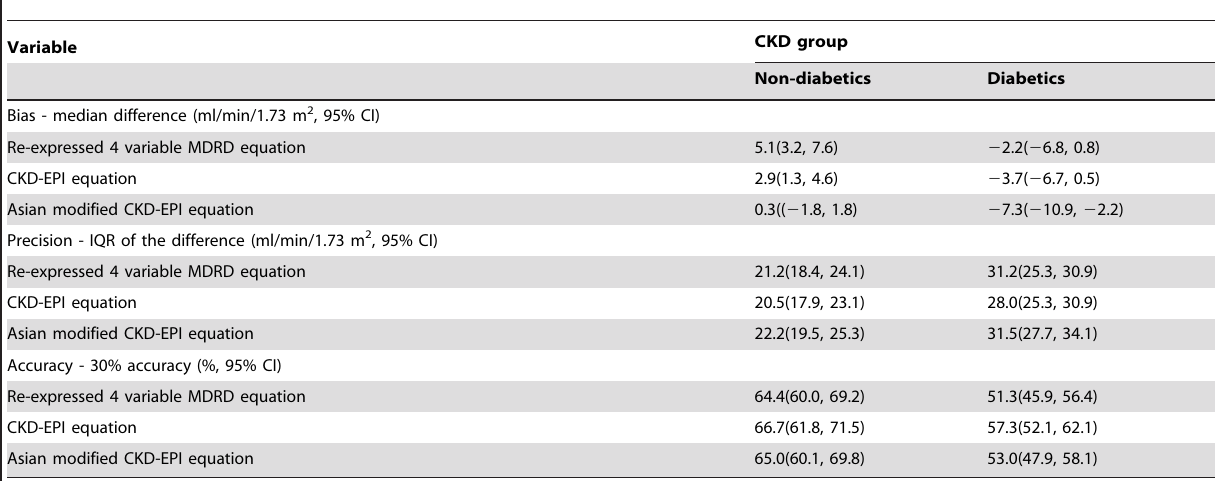
Table 3. Performance between measured GFR and estimated